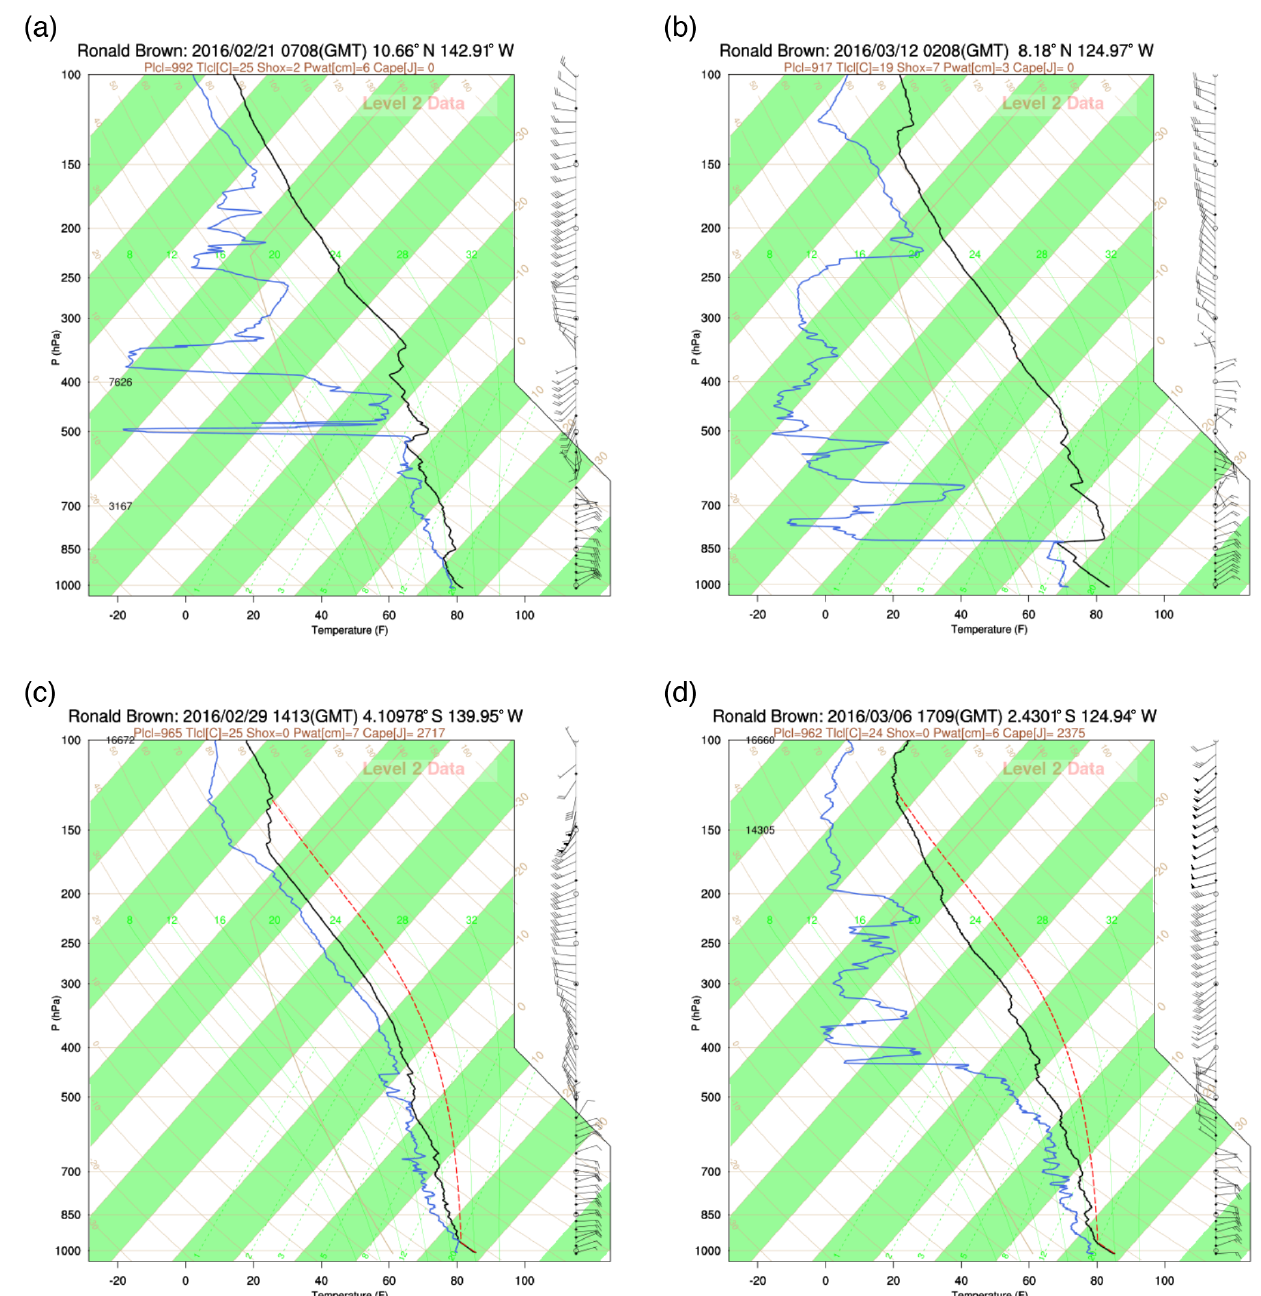
Figure 13. Examples of tropospheric conditions captured by soundings taken from NOAA Ship Ronald H. Brown during ENRR.